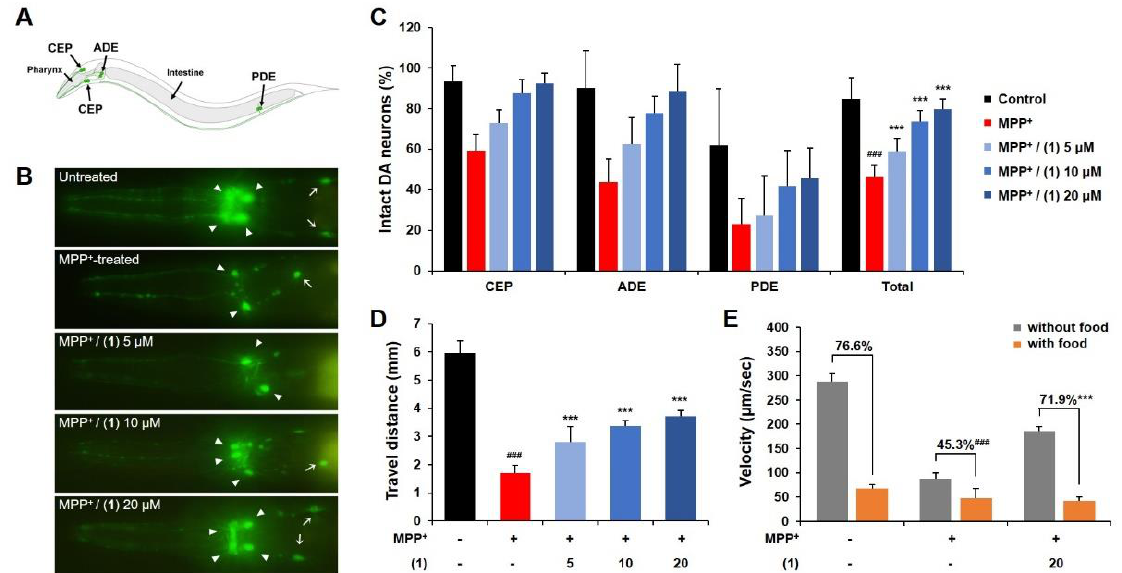
Figure 4. Protective effects of synthesized 1 on the MPP + -induced DA neurodegeneration in C. elegans . ( A ) DA neuronal circuit of C. elegans . ( B ) GFP expression patterns of CEP (arrowhead) and ADE (arrow) in the transgenic strain BZ555 (Pdat-1::GFP) were photographed at 400 × magnification using a fluorescence microscope. ( C ) The viability of all eight DA neurons was scored by inspecting the fluorescence signals of BZ555 worms. ( D ) The movement of individual wild-type worms was tracked for 20 s, and the travel distance was recorded by an automated behavior tracking system under a dissecting microscope. ( E ) The basal slowing response was calculated by measuring the respective velocity of wild-type worms in the presence or absence of food. Statistical significance was determined by one-way ANOVA. ### p < 0.001 compared with vehicle alone. *** p < 0.001 compared with MPP⁺ -treated control. Error bars indicate standard deviation.